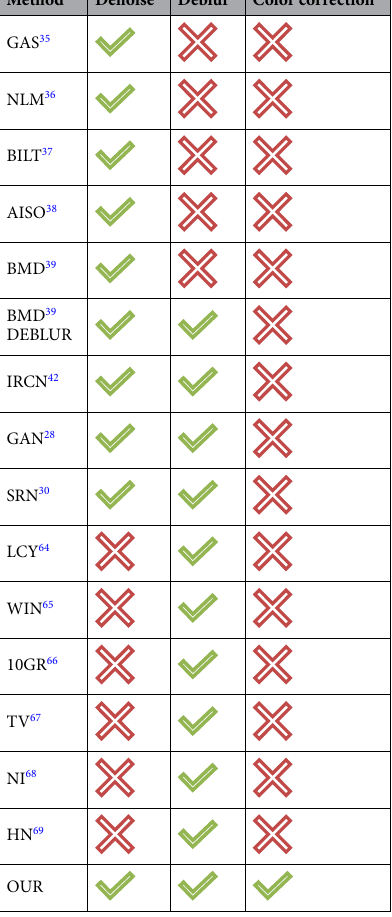
Table 4. Denoise, deblur, and color correction. In this table, means the ability of a method to perform IR task and means the method cannot be applied to perform that IR